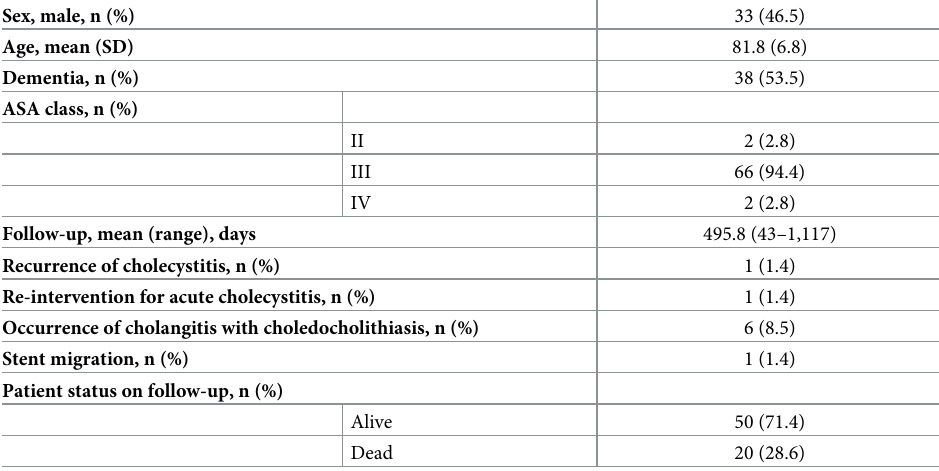
Table 4. Baseline characteristics and long-term outcomes after endoscopic transpapillary gallbladder stenting for acute calculus cholecystitis in 70 patients with high surgical risks.